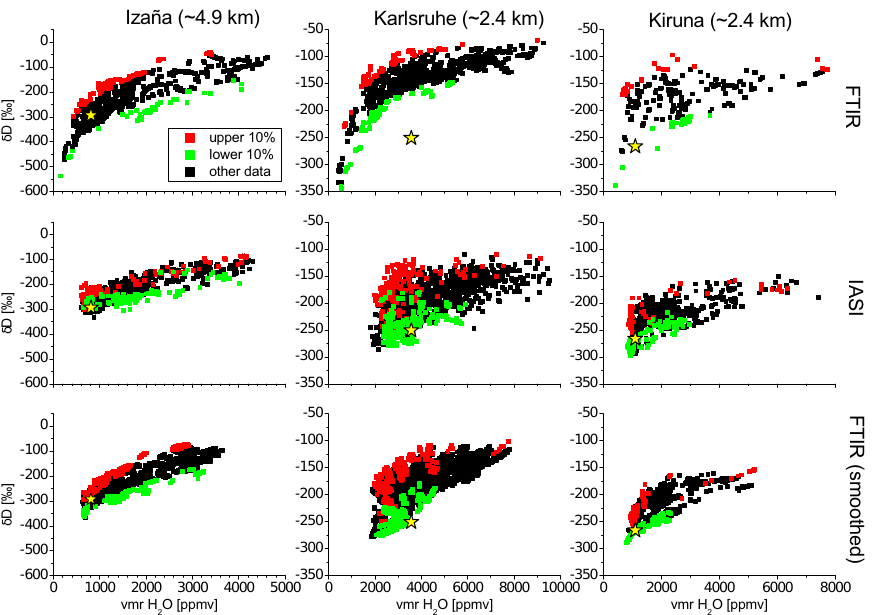
Figure 9. H 2 O-versus- δ D plots for coincident FTIR and IASI measurements for the three locations. Plotted are (from the top to the bottom) the FTIR data, the IASI data, and FTIR data smoothed with the IASI averaging kernels. The colour code displays the upper 10% and lower 10% of δ D values as identified in the FTIR data. The yellow stars mark the a priori values that are similar for FTIR and